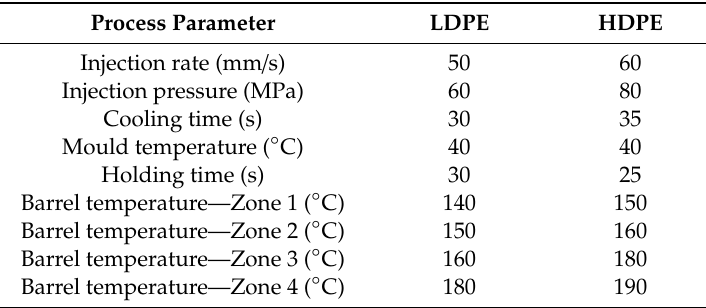
Table 2. Process